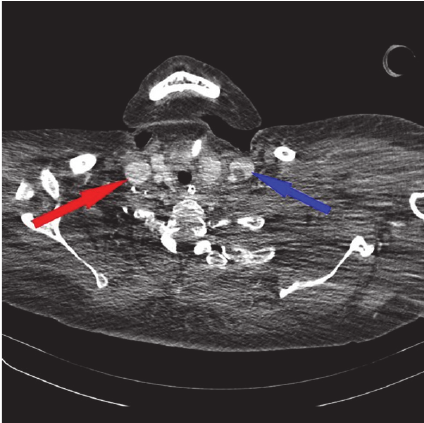
Figure 1: CT scan (axial image) of the thorax with a contrast enhancing agent. Results with thrombus adhering to the wall in both internal jugular veins (left IJV, blue arrow, and right IJV, red arrow).